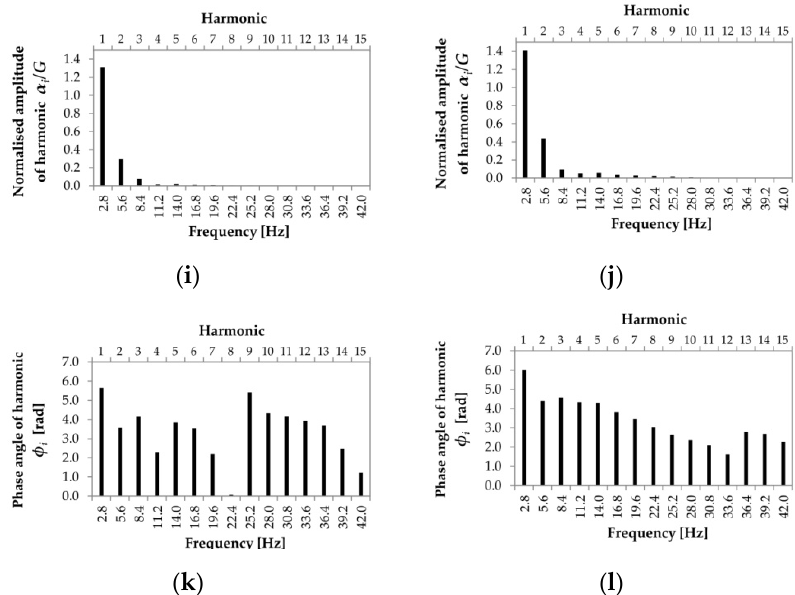
Figure 6. Sample charts of the F VGRF curves generated by forefoot-strike runners ( f r = 2.80 Hz) and their corresponding amplitudes and phase angles for 15 harmonics: ( a , b , g , h ) examples of the F VGRF curves; ( c , d , i , j ) normalised amplitudes of the F VGRF harmonics; ( e , f , k , l ) phase angles of the F VGRF harmonics (The data presented can be found in supplementary materials in the form of text files containing numerical data. See section Supplementary materials).